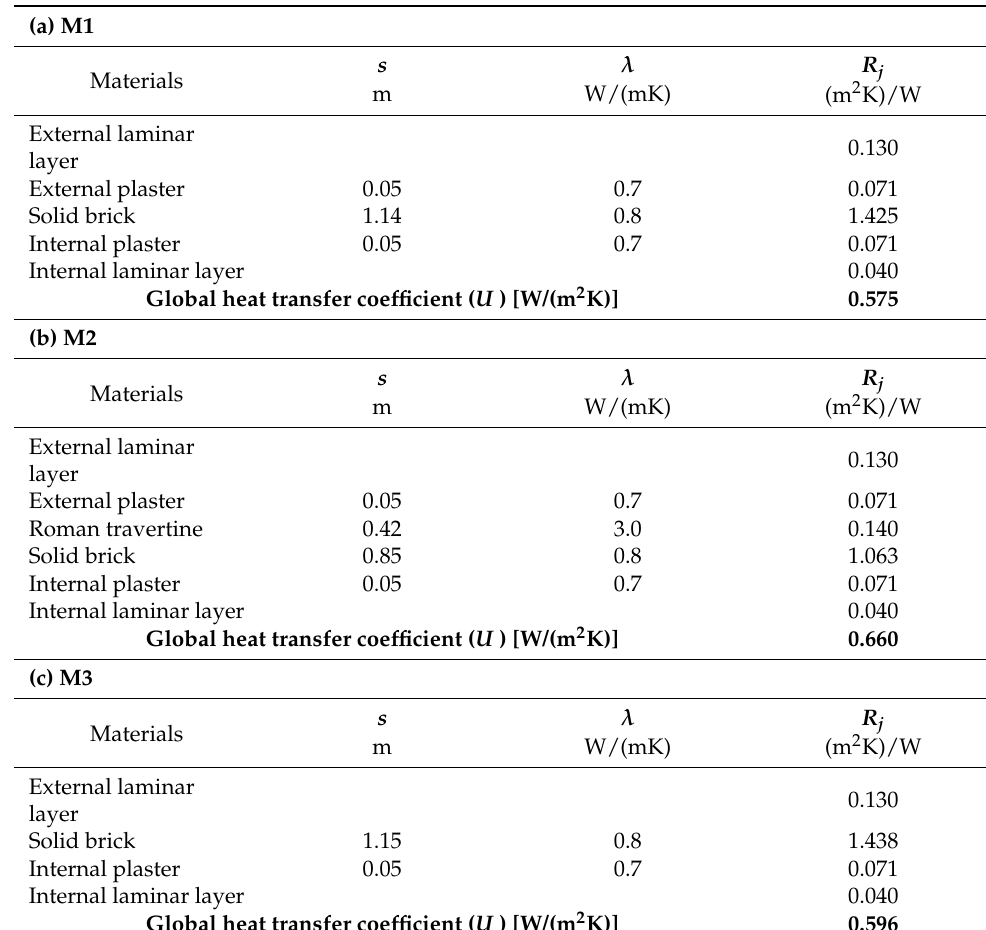
Table 2. Dimensions and thermophysical characteristics of the investigated façades: M1 ( a ), M2 ( b ), M3 ( c